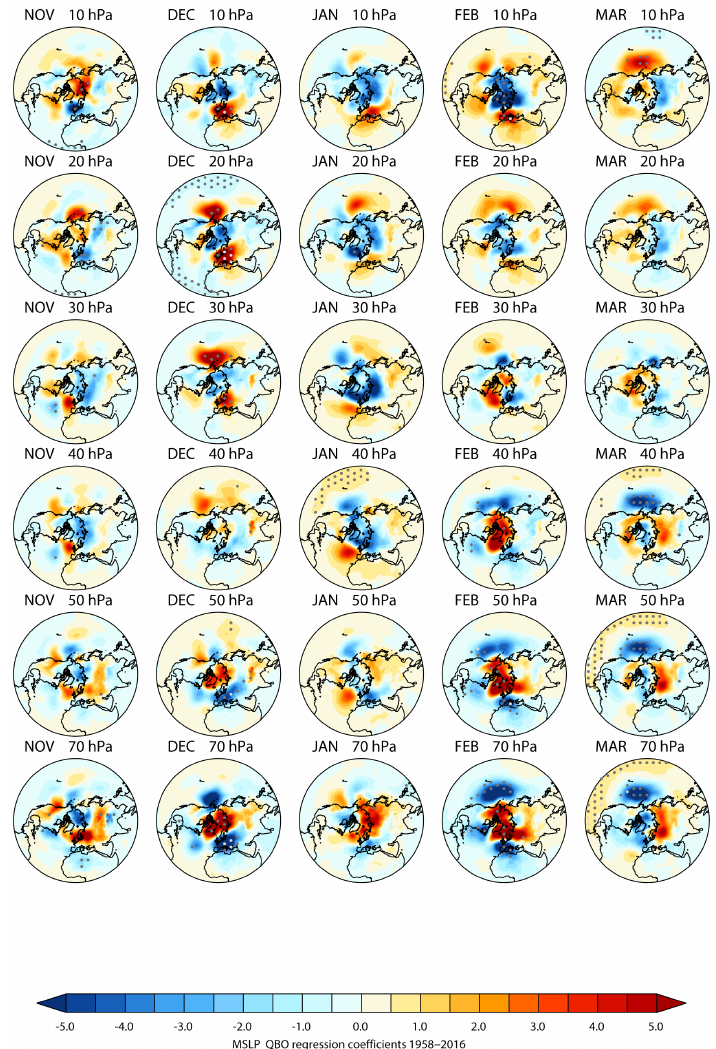
Figure 8. As Fig. 7 but with an additional index included in the regression analysis to represent the polar vortex